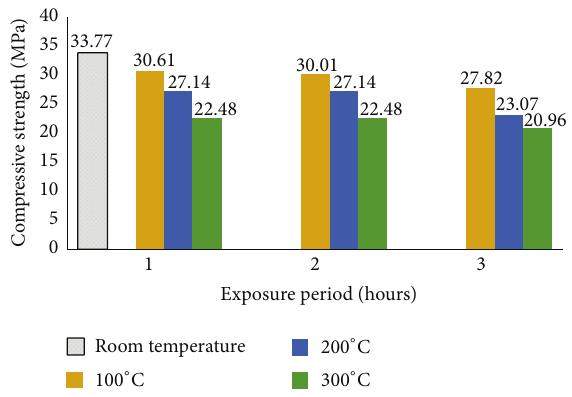
Figure 8: Average compressive strength of GFRP confined specimens after exposure to different temperatures.